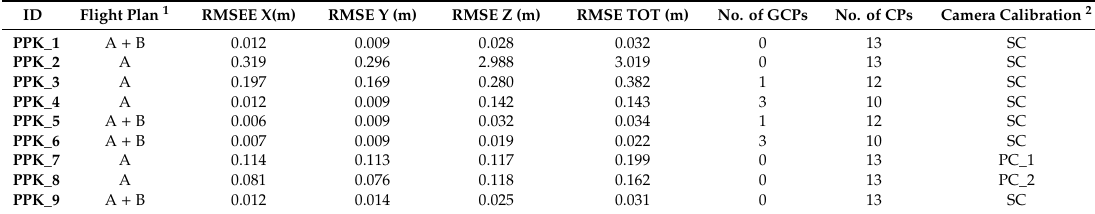
Table 10. PPK approach. RMSE on CPs for configuration from PPK_1 to PPK_9.